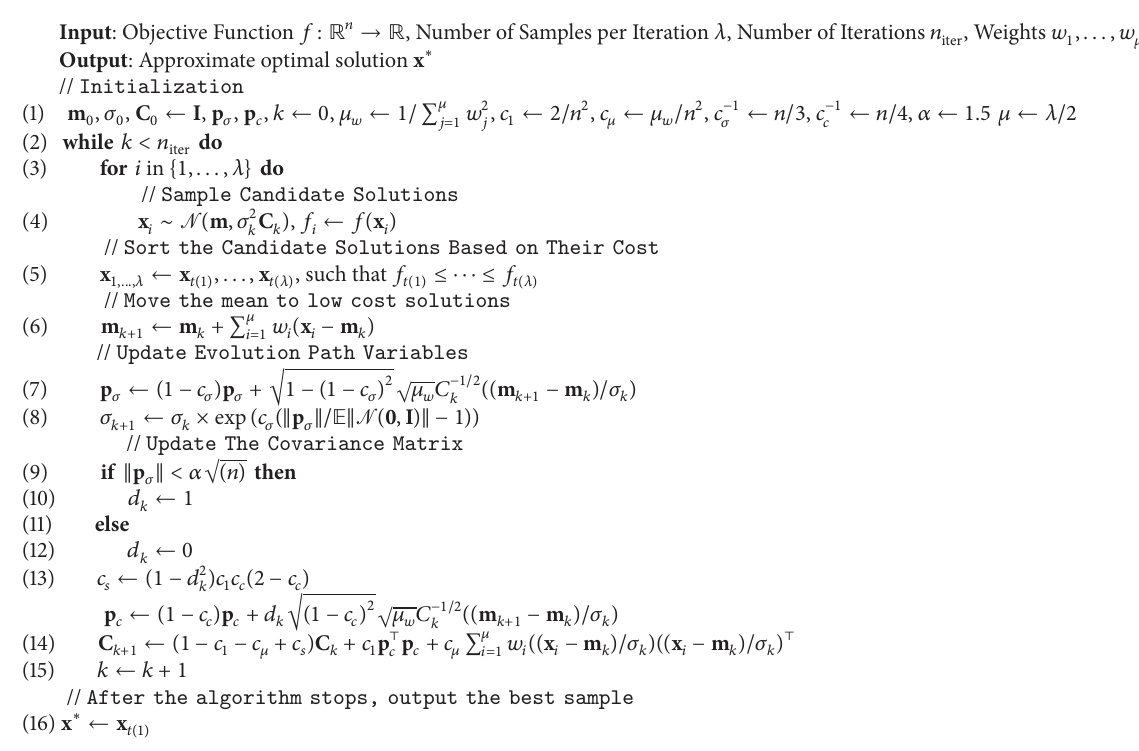
Algorithm 1: Covariance Matrix Adaptation